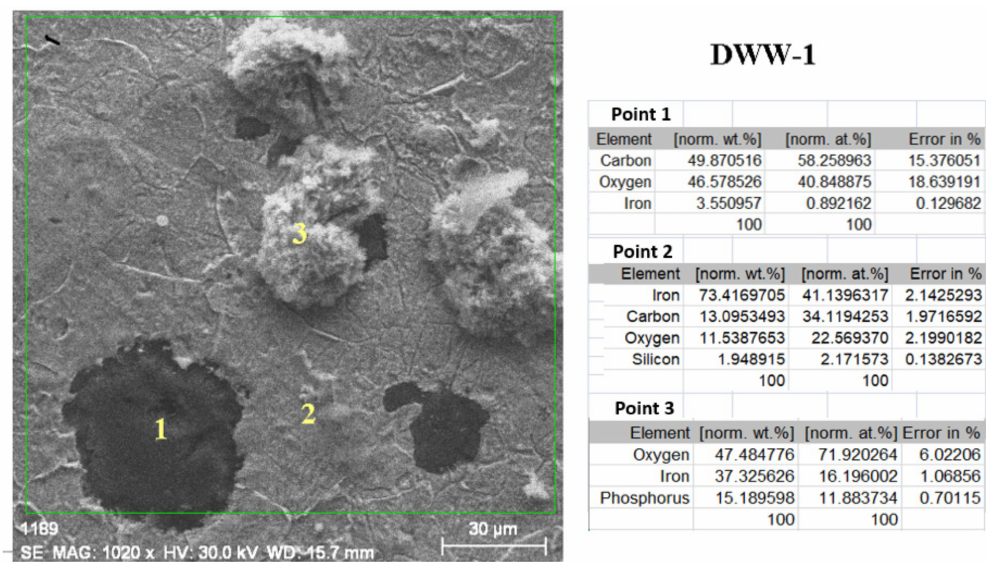
Figure 12. Punctual EDS microanalysis of the sample surface immersed for 30 days in DWW-1.